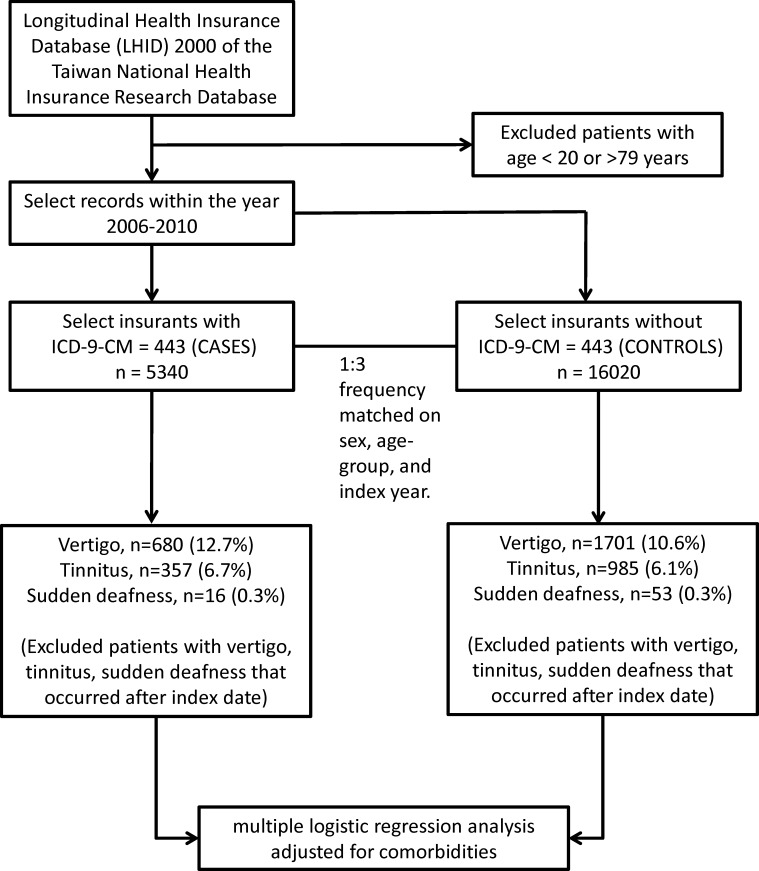
Flow diagram of study design.ICD-9-CM: International Classification of Diseases, 9th Revision, Clinical Modification.